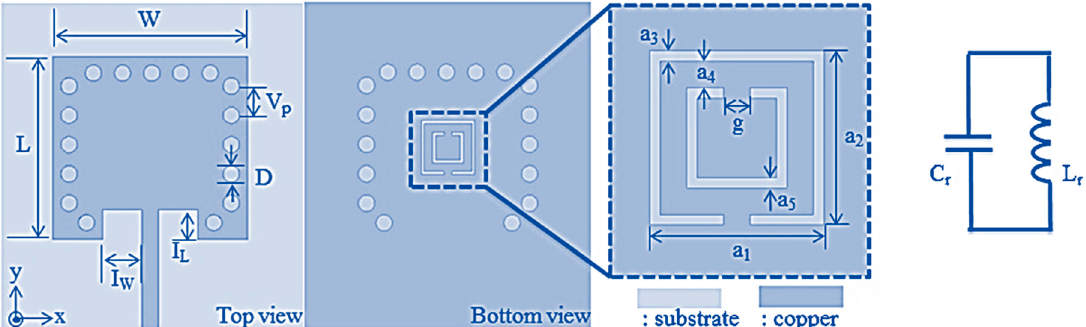
Figure 27. Planar view of the CSRR ‐ loaded substrate ‐ integrated ‐ waveguide (SIW): ( a ) top view, ( b ) bottom view, ( c ) CSRR and ( d ) lossless equivalent circuit model of the CSRR (from [41]; copyright © 2014; reproduced with permission).